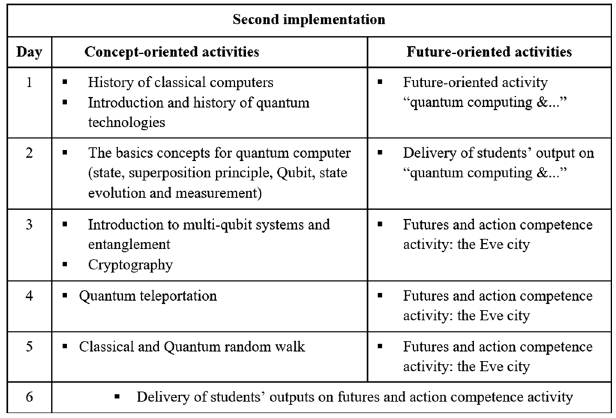
FIG. 26. Second implementation ’ s